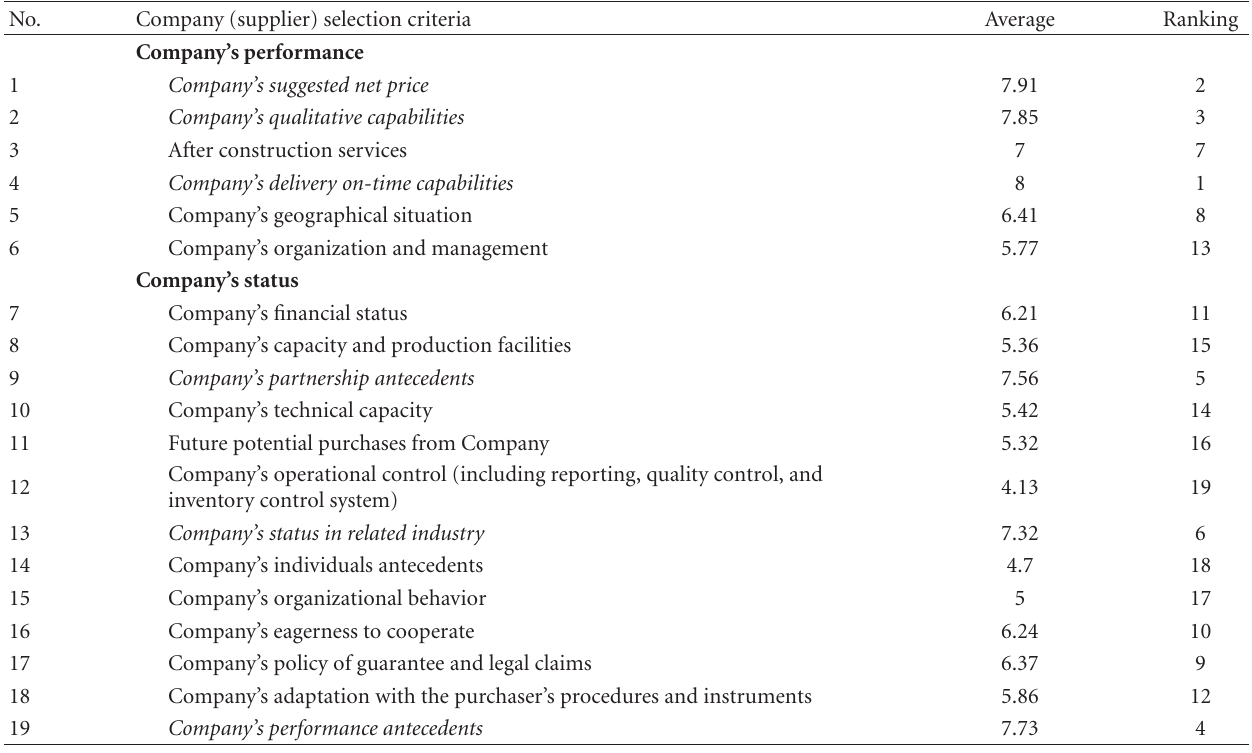
Table 2: Final result for evaluating criteria and italicized criteria.